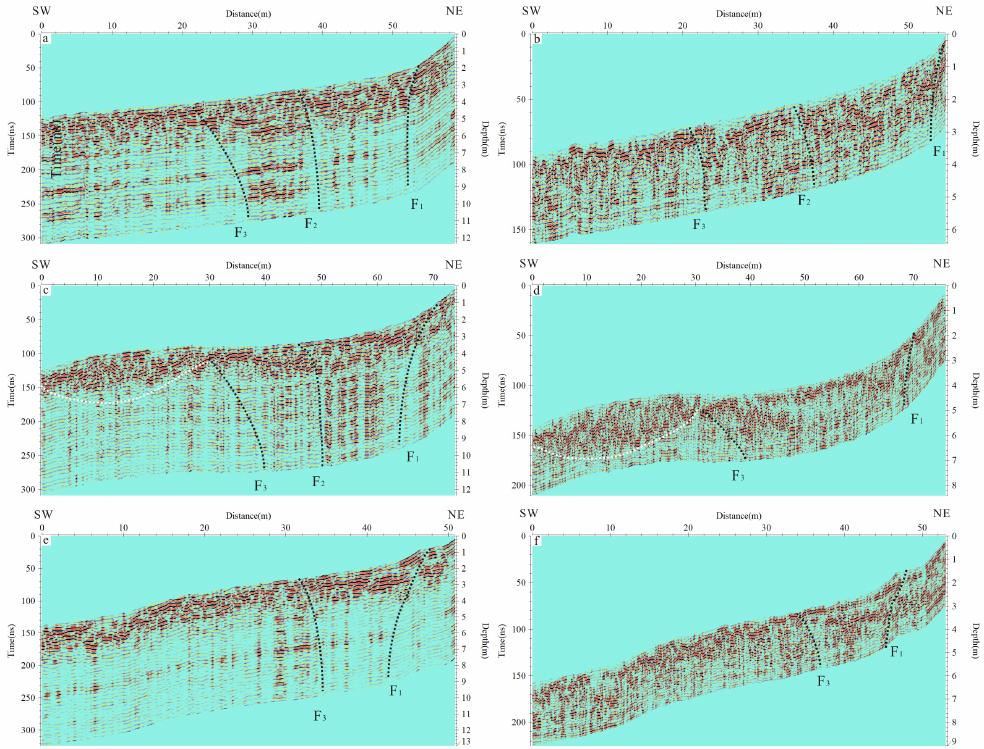
Figure 10. The 250 MHz and 500 MHz GPR interpreted images. ( a , b ) show the 250 MHz and 500 MHz interpreted GPR results in the survey line 2. ( c , d ) show the 250 MHz and 500 MHz GPR im- ages in the survey line 3 and ( e , f ) are the processed 250 MHz and 500 MHz GPR images in the survey line